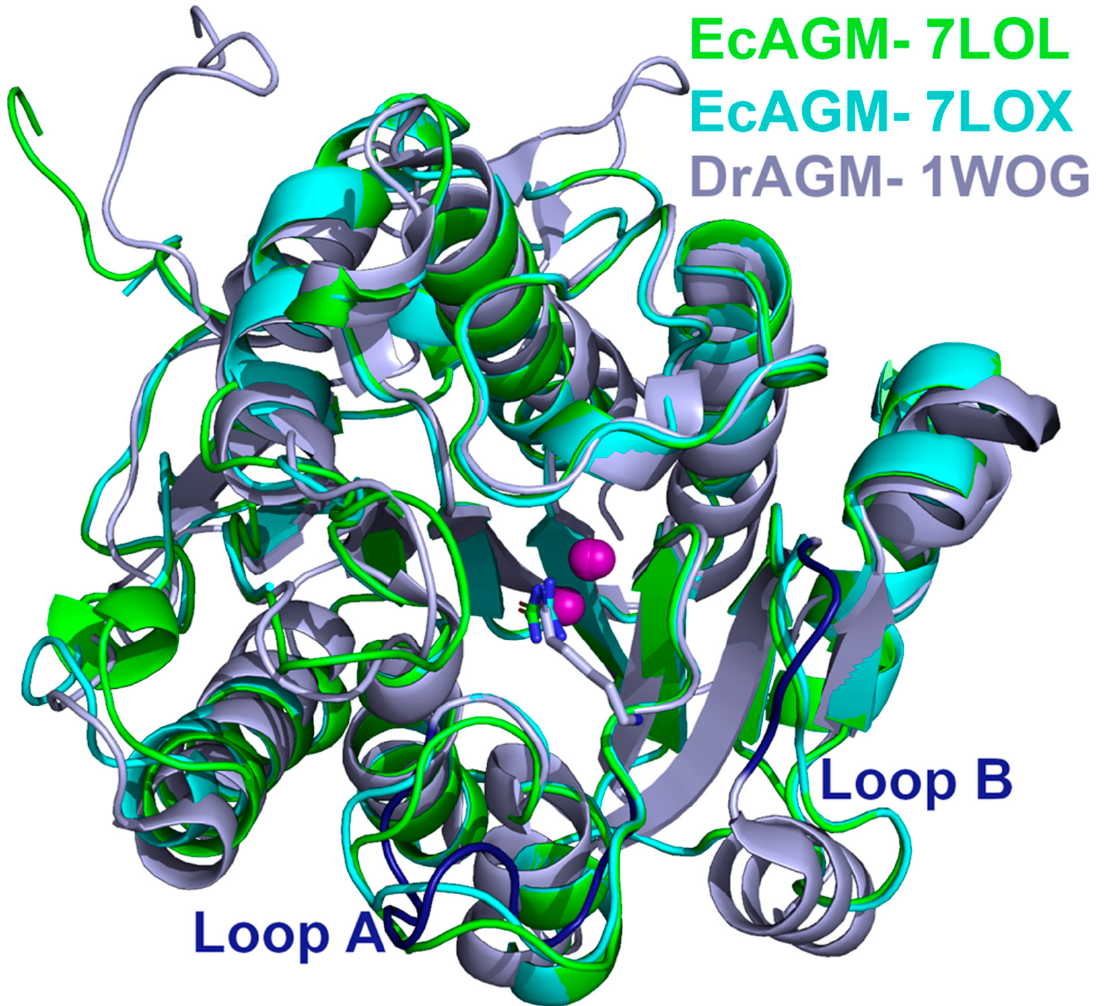
Figure 5. Structural comparison of EcAGM and DrAGM . EcAGM 7LOL and 7LOX are shown as green and cyan cartoons, respectively. DrAGM (PDB 1WOG) is shown as light blue, and its loops A and B are colored in dark blue. Guanidine, urea, and hexane-1,6-diamine are shown as sticks. Mn 2+ ions are shown as purple spheres.